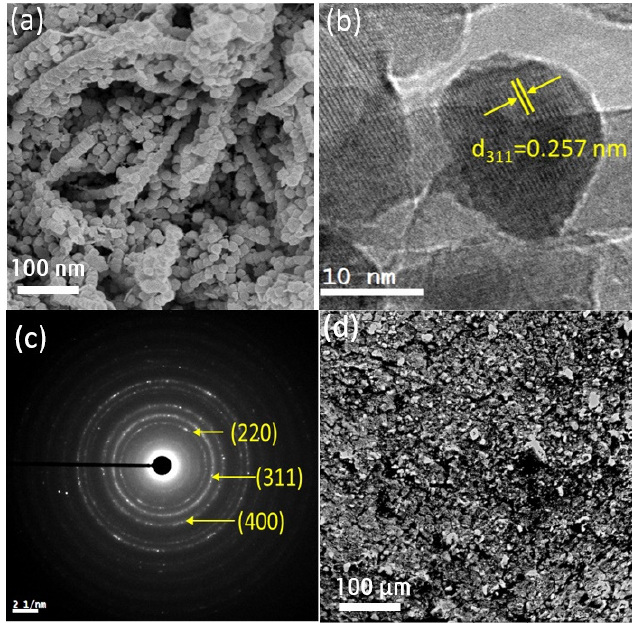
Figure 2. ( a ) SEM, ( b ) HRTEM and ( c ) SAED of MnFe 2 O 4 . ( d ) Top view SEM of PANi@MnFe 2 O 4 photoelectrode